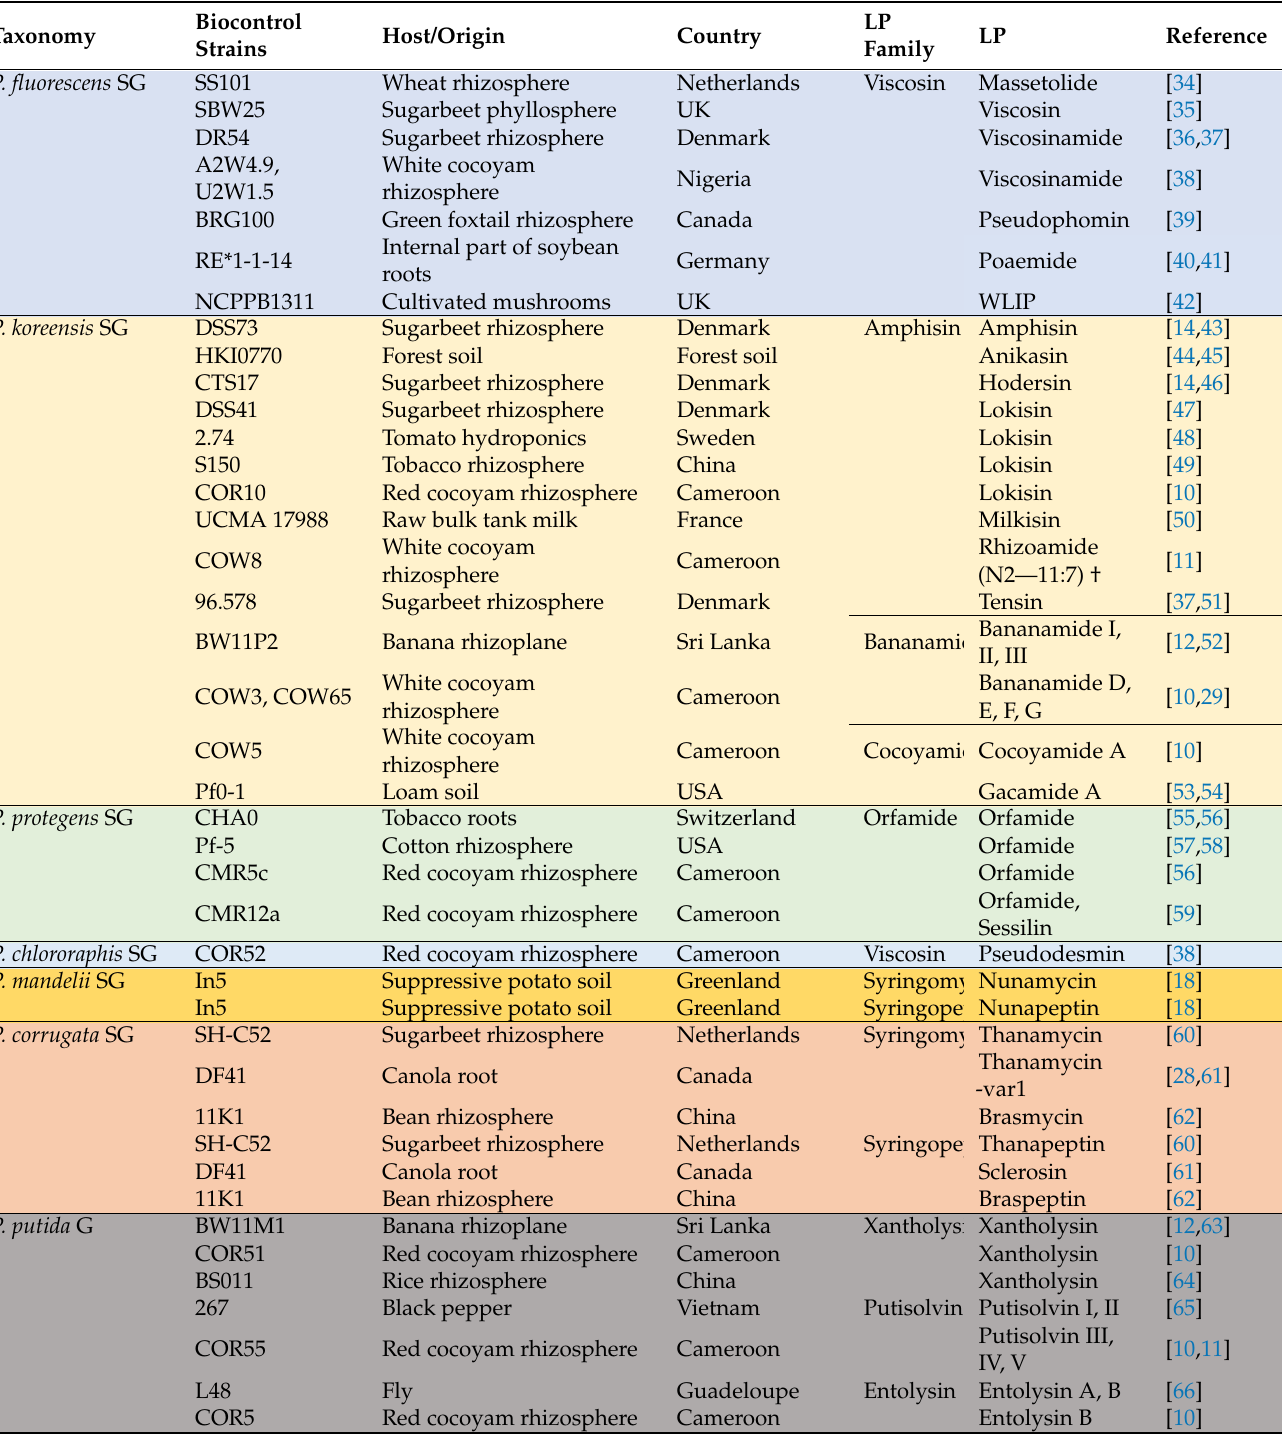
Table 1. Taxonomy of LP-producing Biocontrol Pseudomonads, their corresponding Molecules and